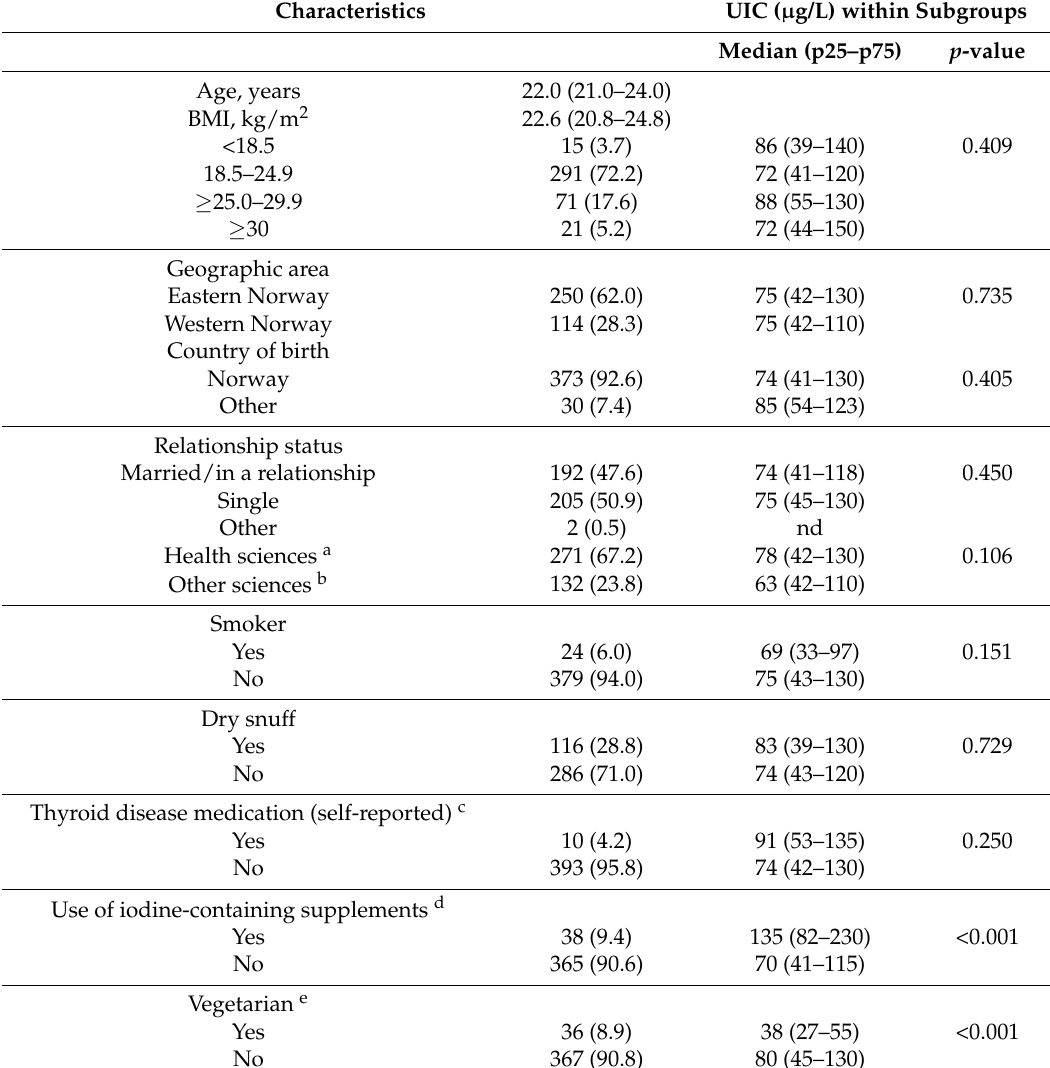
Table 1. Sample characteristics and median urinary iodine concentration (UIC) among young Norwegian women ( n =